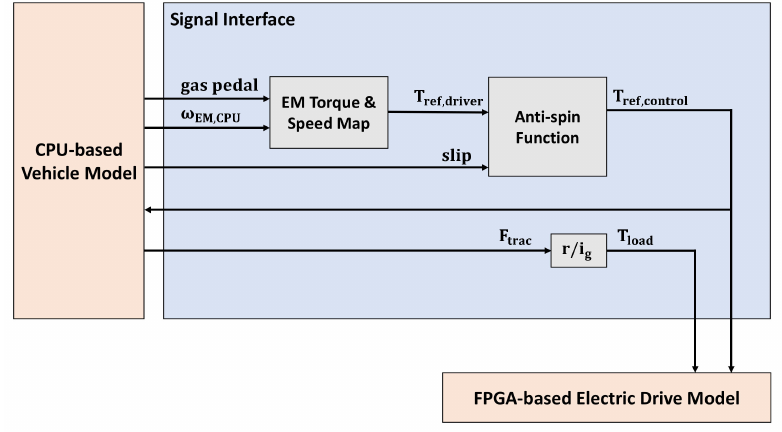
Figure 4. Open-loop interface between the vehicle model and the electric drive model.